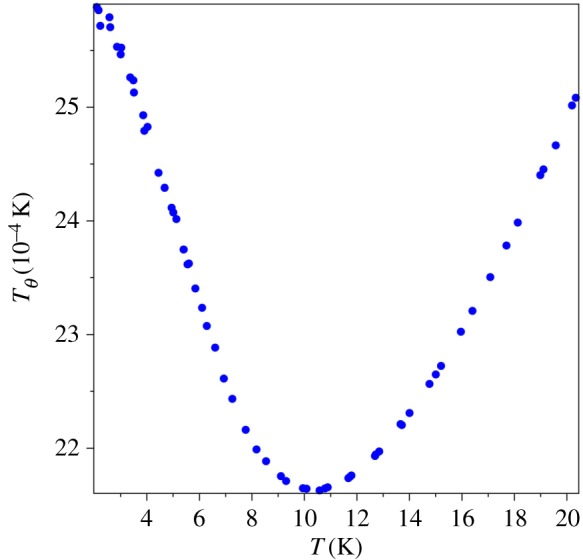
Tθ(T) for AgCl [35].